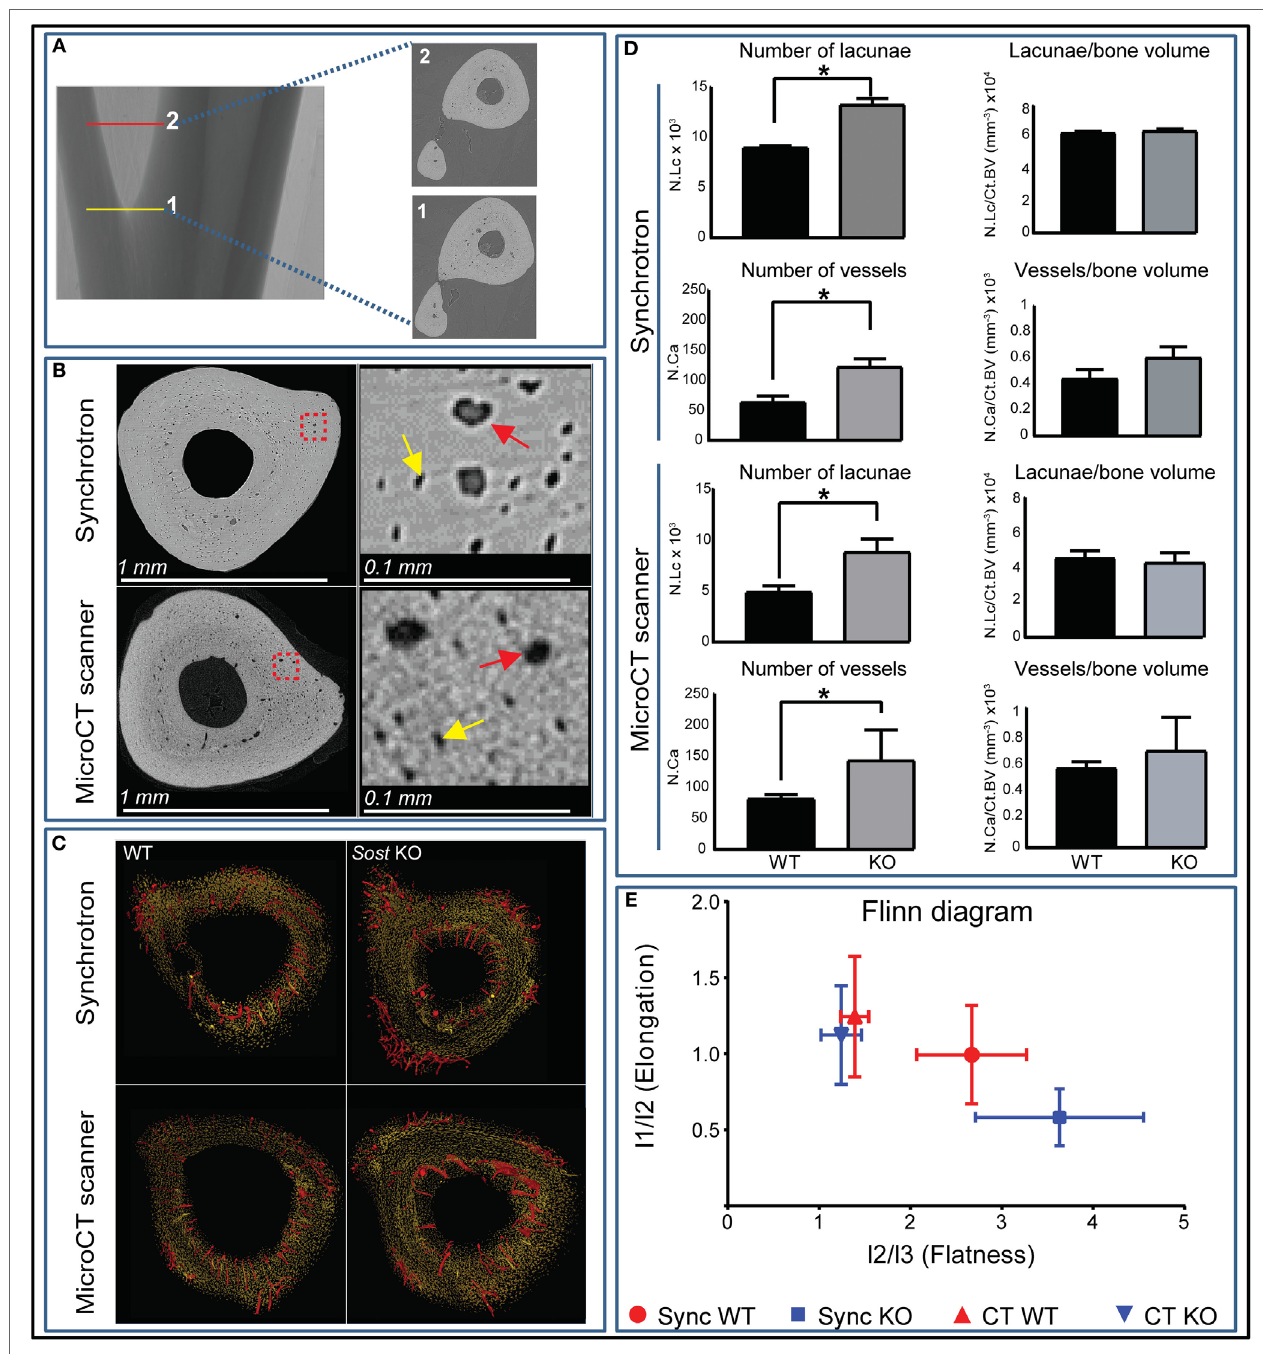
FigUre 2 | High-resolution nano-computed tomography (nanoCT) and synchrotron-based analysis of the cortex lacunar and vascular porosity at the tibiofibular junction. (a) Three 100 ascending images were selected from point 1 at the tibiofibular junction to point 2 and were used for porosity analysis. (B) Resolving power and gross macroscopic comparison of images obtained from the nanoCT and the synchrotron. Higher magnification quadrants are also shown right side of their respective images for better appreciation. Yellow and red arrows depict selected lacunar and canal pores in both imaging modalities. (c) Surface representation of the lacunar (yellow) and red (vascular canal porosity) segmented from 300 consecutive images from tibiofibular junction of wild-type (WT) and Sost knockout (KO) mice. (D) Number of lacunar pores and vascular canals of WT and Sost KO mice at 12 weeks of age. (e) Flinn diagram displaying lacunar shapes in WT and Sost KO tibia at tibiofibular junction. The x -axis represents lacunar flatness which was calculated by dividing lacunar intermediate radius (l2: length of best-fit ellipsoid’s intermediate radius) with lacunar minor radius (l3: length of best-fit ellipsoid’s minor radius). The y -axis represents lacunar elongation which was calculated by dividing lacunar major radius (l1: length of best-fit ellipsoid’s major radius) with lacunar intermediate radius (l2: length of best-fit ellipsoid’s intermediate radius). WT and Sost KO tibiae scanned at the synchrotron were from a separate batch compared to micro-CT and bench top nanoCT. Two-sample t -test was used to compare means between WT and Sost KO mice. Data represent means ± SEM with group sizes of n = 6 for WT and Sost KO